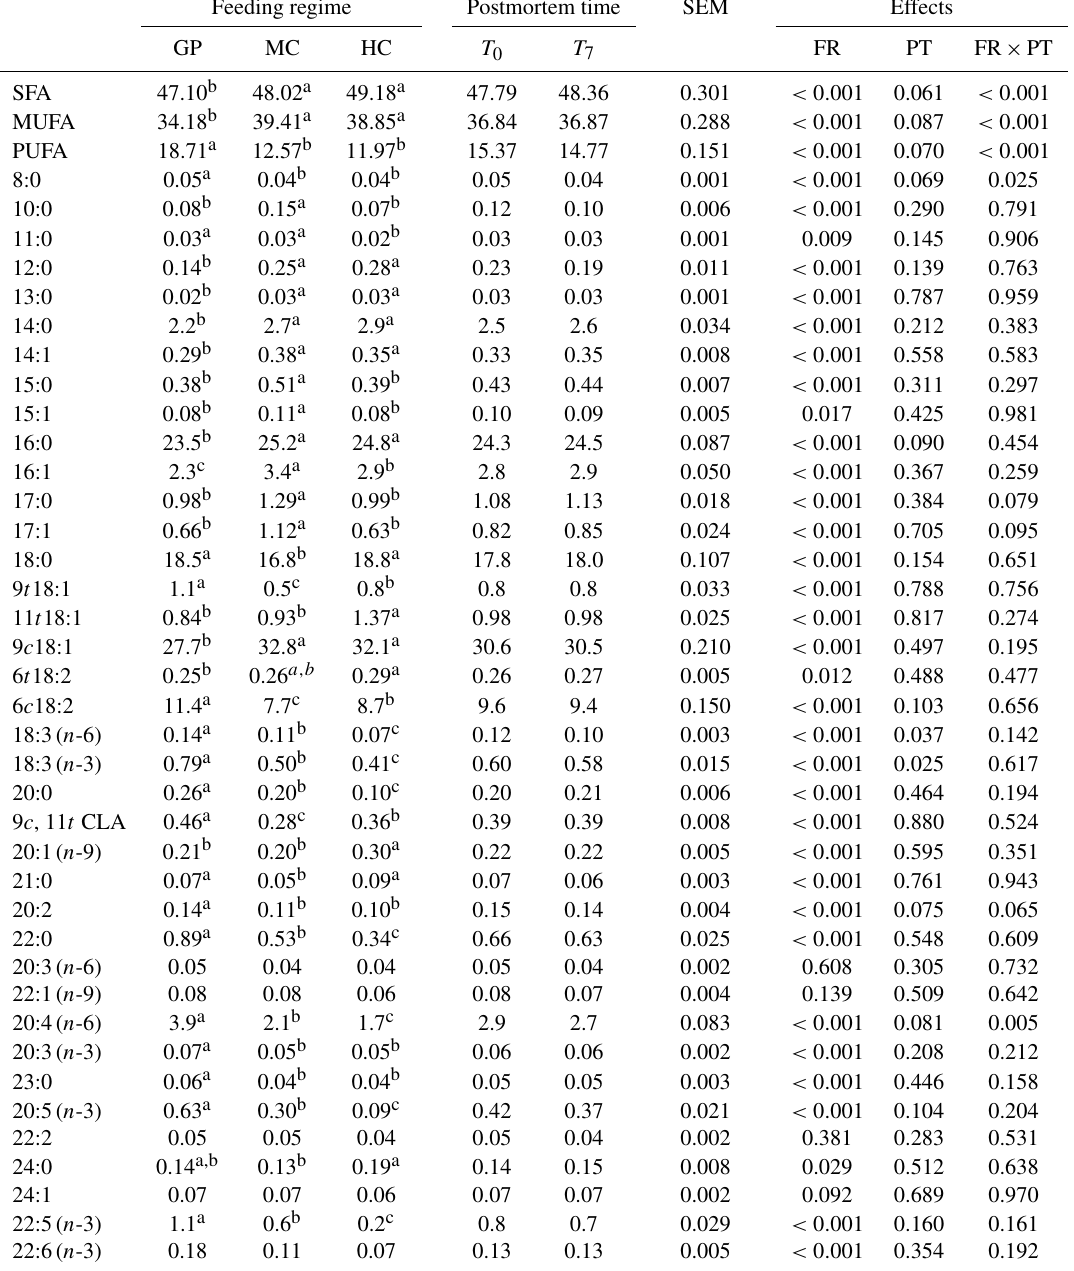
Table 3. Effect of feeding regimes (grass pasture, GP; medium level concentrate, MC, and high level concentrate, HC) and postmortem time ( T 0 and T 7 represent 0 and 7d, respectively) on fatty acid profile (expressed as a percent of the total fatty acids detected) in intramuscular fat from young Retinta